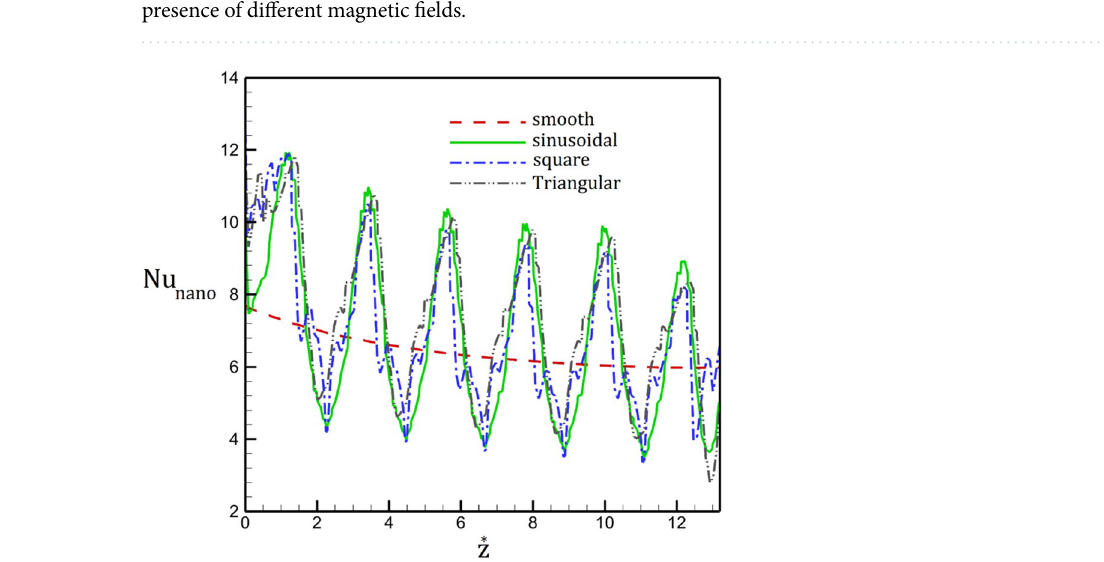
Figure 13. Comparison of Nusselt number along the tube without magnetic